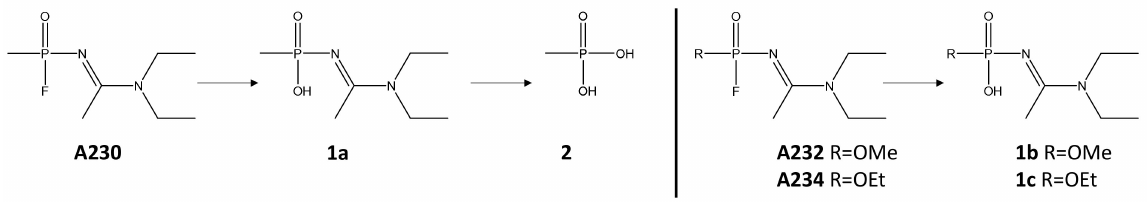
Figure 3. Degradation reactions of Novichok agents observed in this